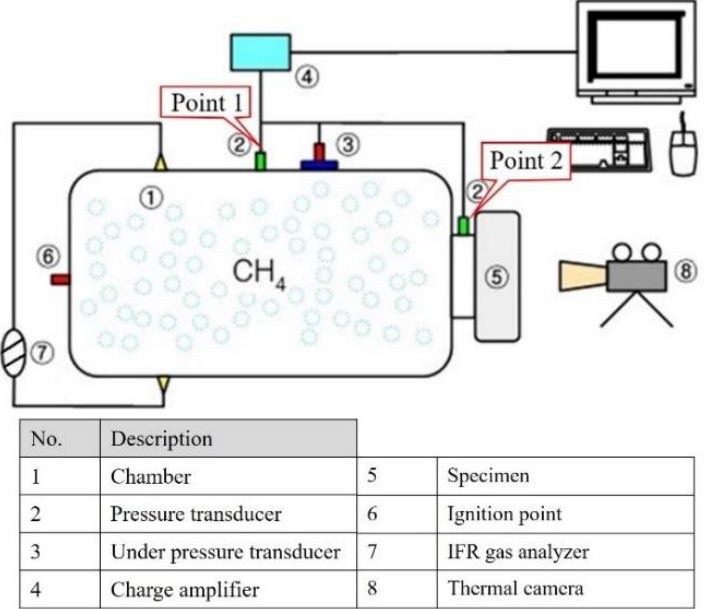
Figure 9. Configuration of explosion test apparatus and pressure measured points.